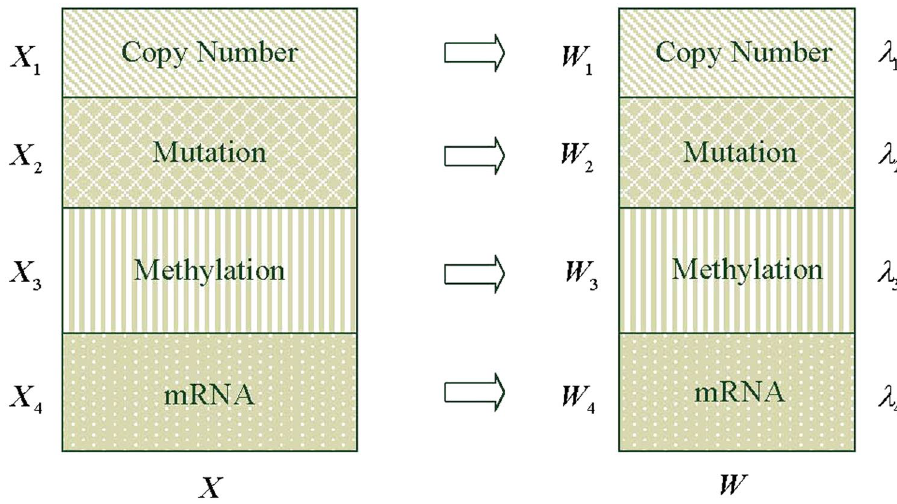
Figure 2. The OMBRFE model for cancer gene identification from colorectal cancer integrated